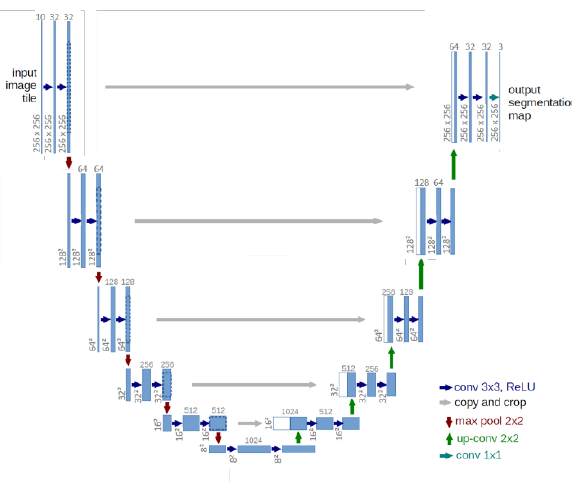
Figure 1 . Architecture of the U-Net variation used in this study. Image source: Modified after Ronneberger et al.